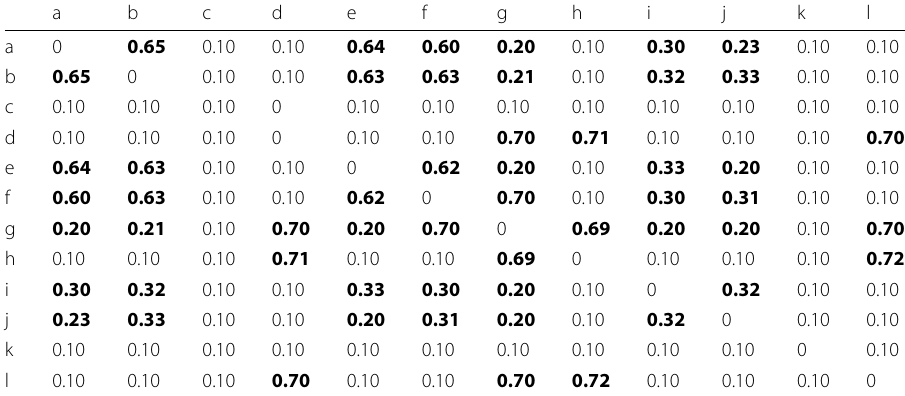
Table 1 Synthetic coherence